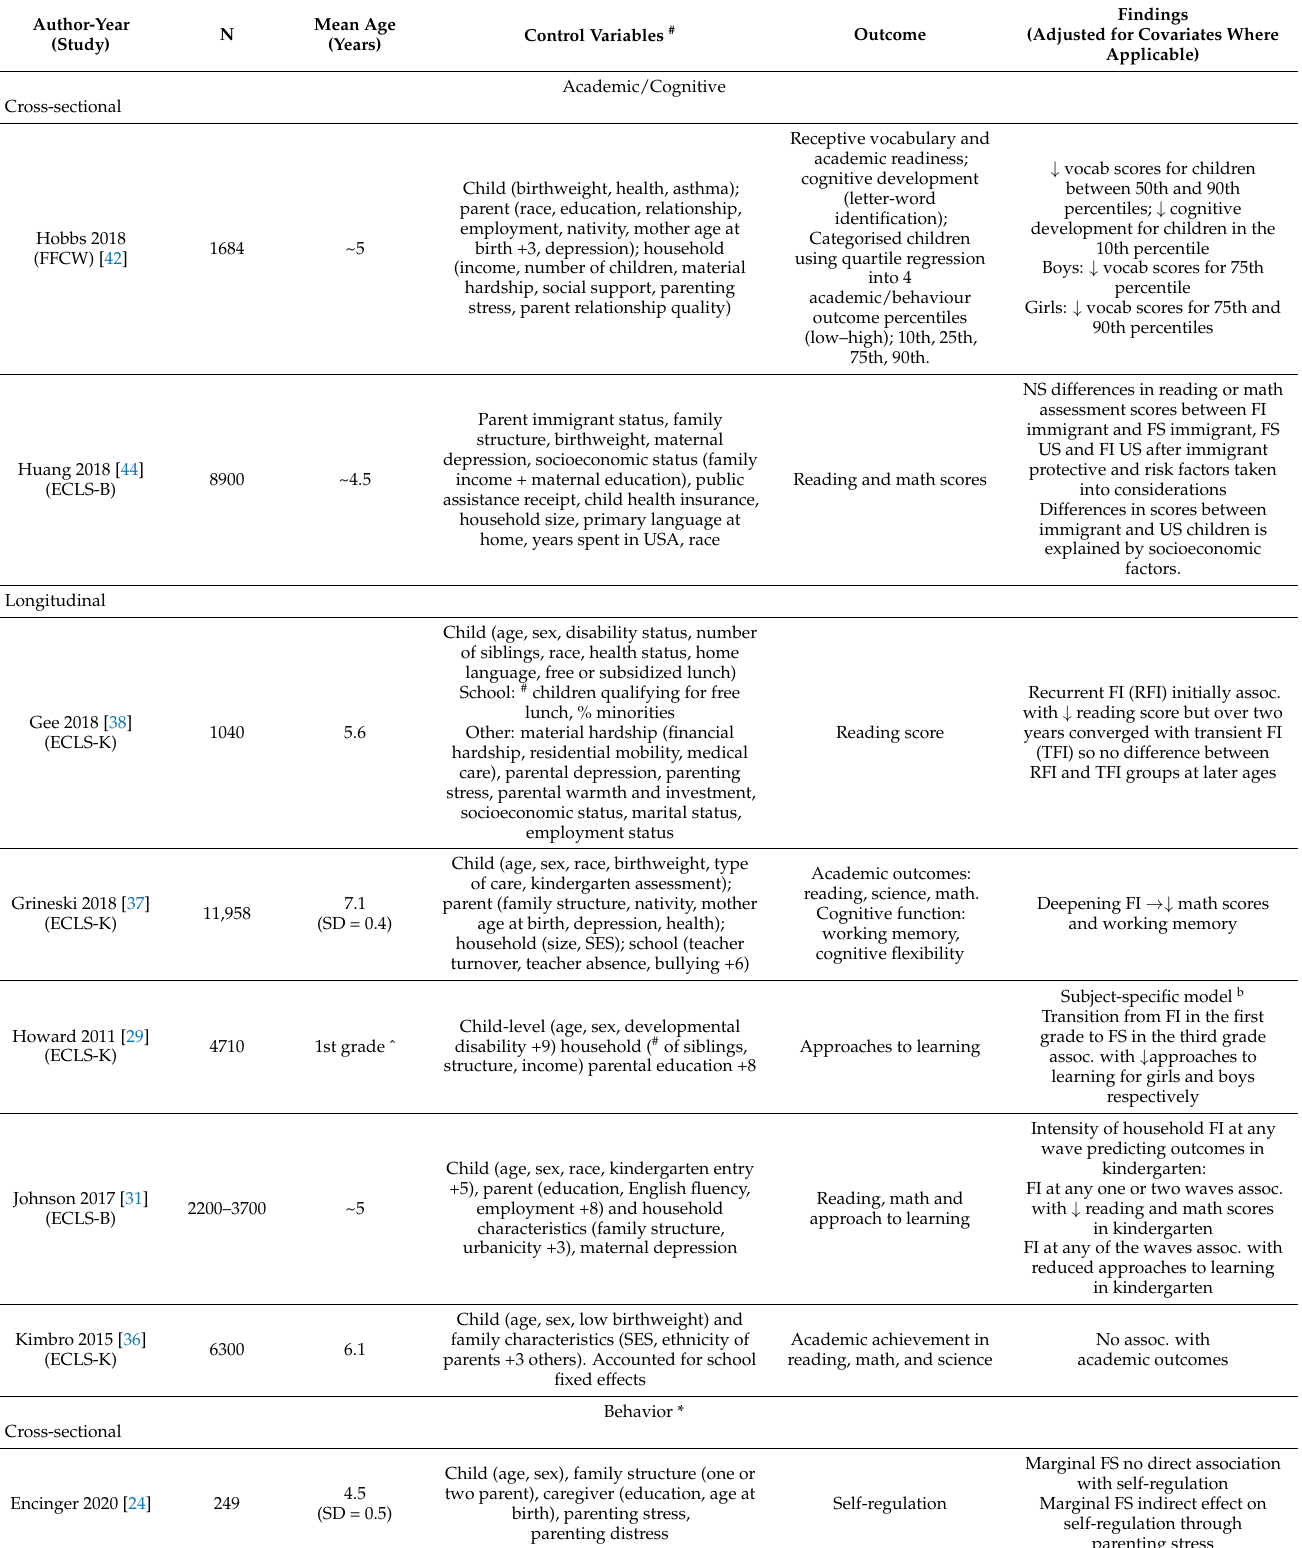
Table 3. Summary of food security and child development